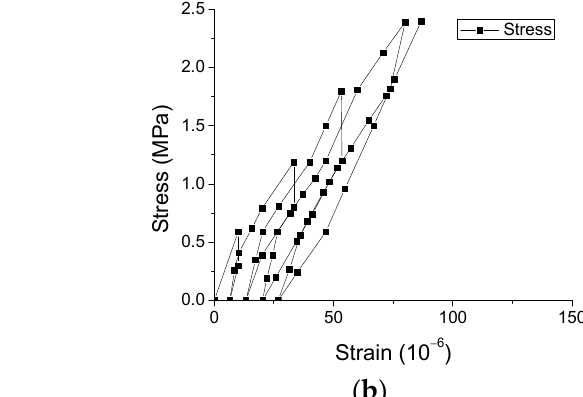
Figure 7. Typical experimental results of stress-strain curves for SCC prismatic specimens under cyclic direct tension. ( a ) Sample T-Prism 6 and ( b ) Sample T-Prism 7.